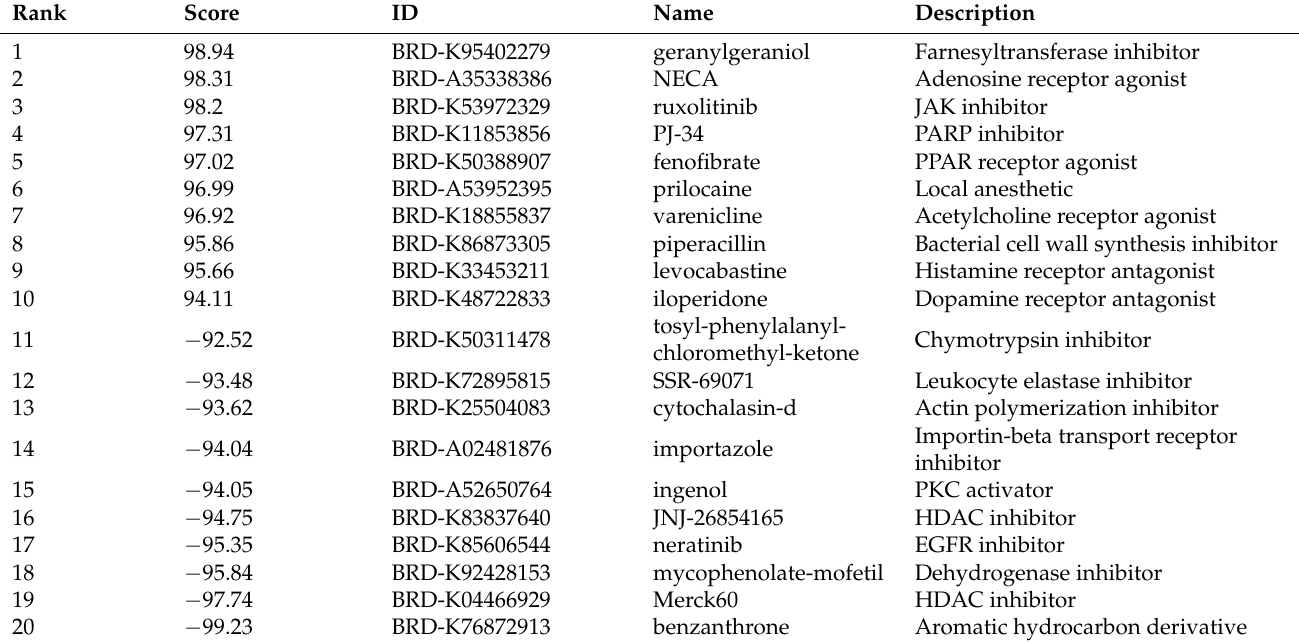
Table 4. The top 10 and bottom 10 potential compounds.